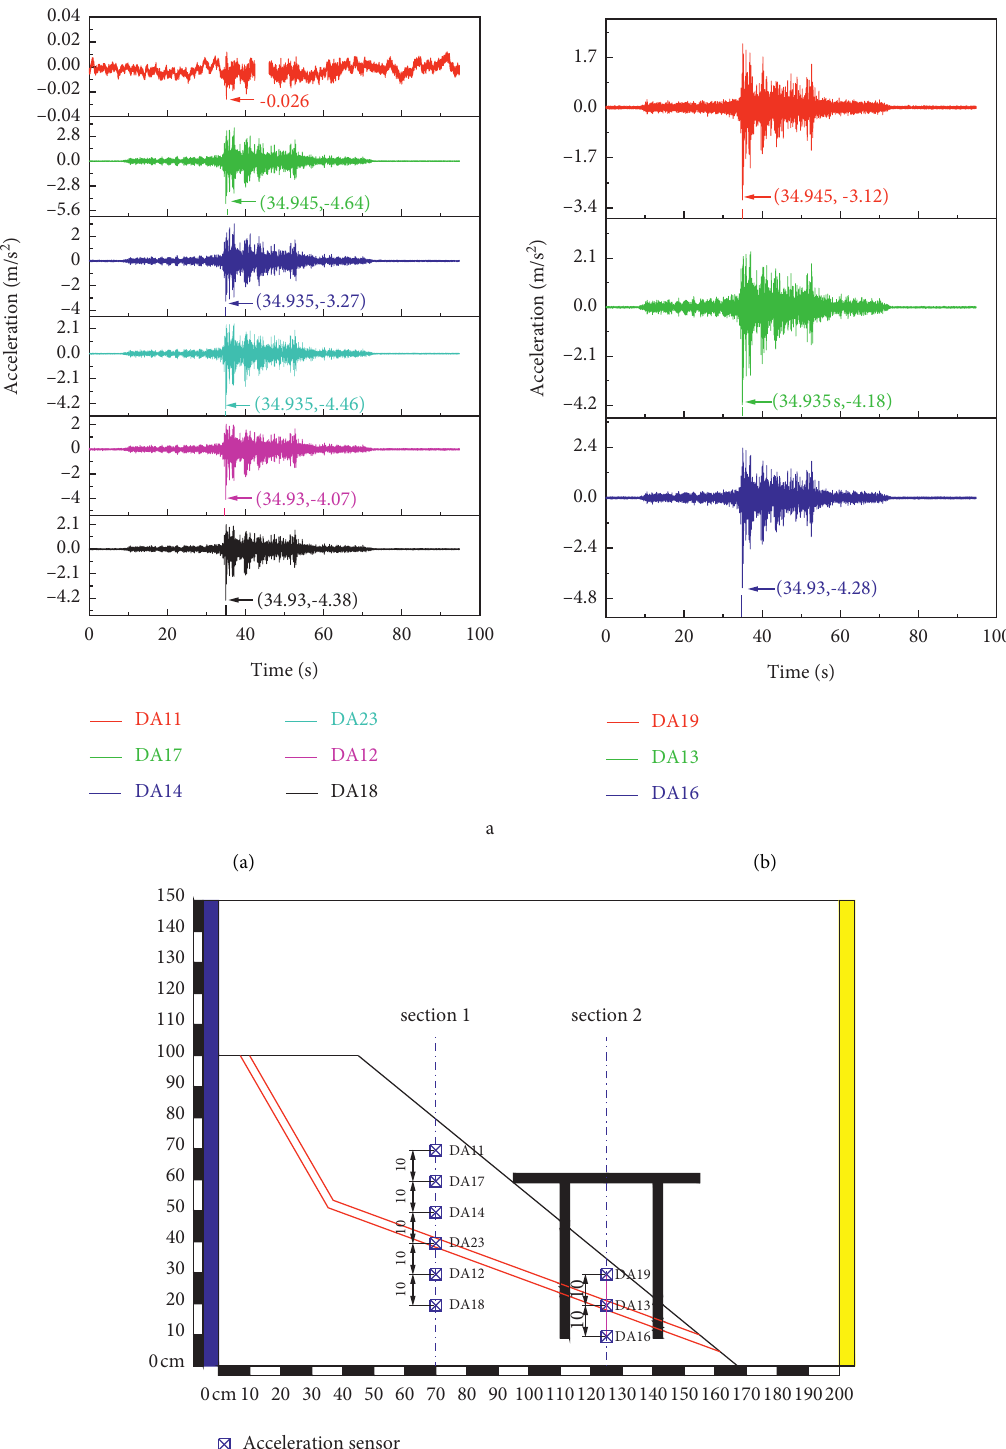
Figure 8: Acceleration time-history curves of different elevation measuring points in different sections (0.4g). (a) Acceleration time-history curves of different elevation measuring points in section 1. (b) Acceleration time-history curves of different elevation measuring points in section 2. (c) Sensor location